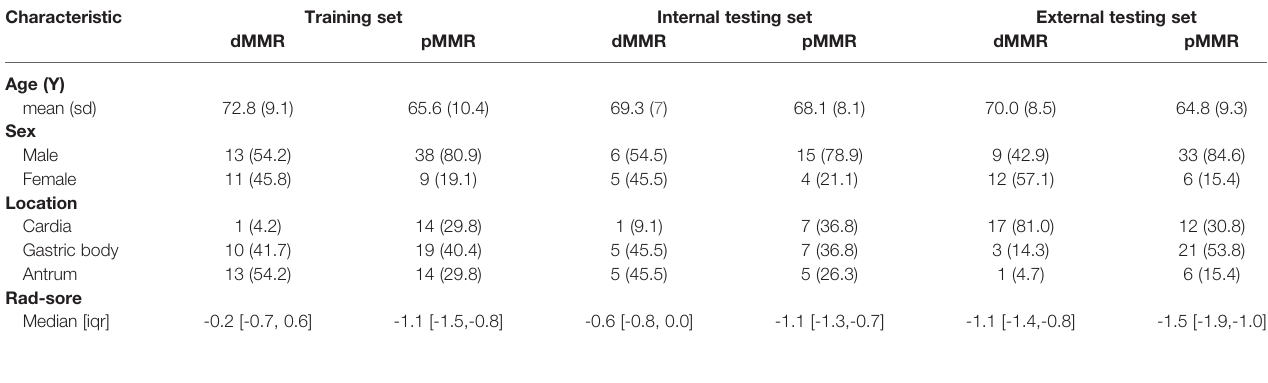
TABLE 1 | Clinic-radiological characteristics of patients in the training and testing sets. Characteristic Training